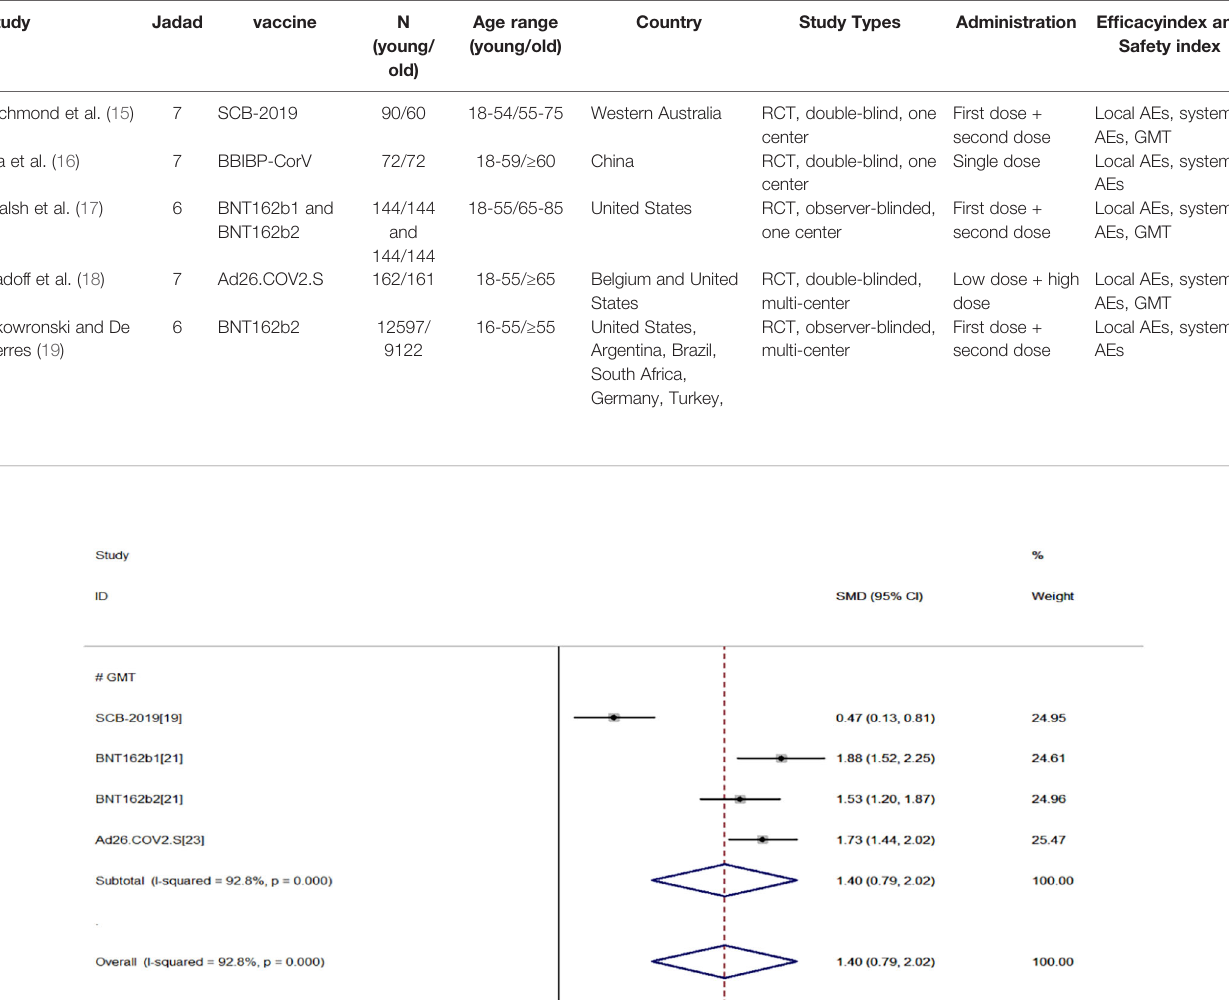
TABLE 1 | Characteristics of included studies and Jadad scores.